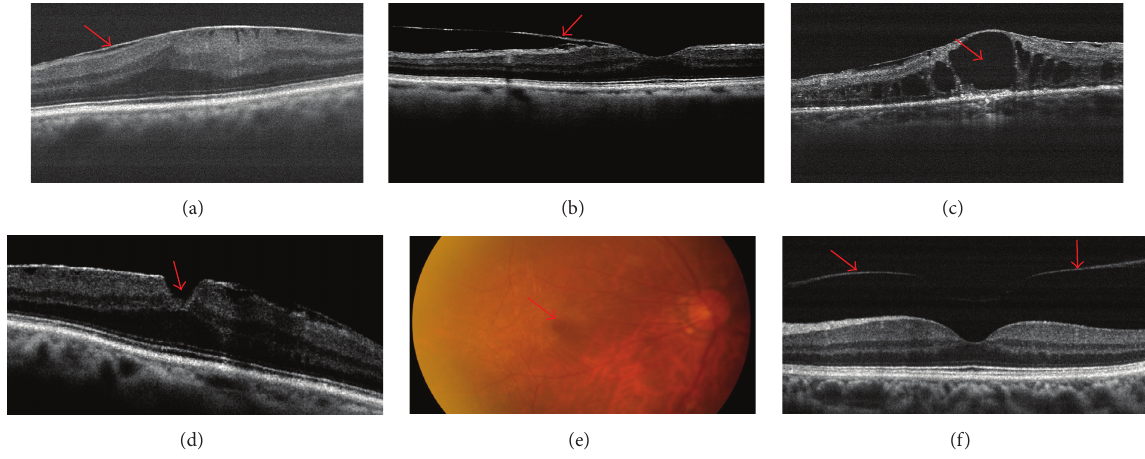
Figure 2: (a) Representative epiretinal membrane (ERM) image; (b) vitreomacular traction syndrome (VMT) image; (c) representative macular cysts/macular edema (MC/ME); (d) representative full-thickness macular hole (FTMH) image and representative partial thickness macular hole (PTMH) image; (e) representative posterior vitreous detachment (PVD) image. The red arrows indicate abnormities of fundus